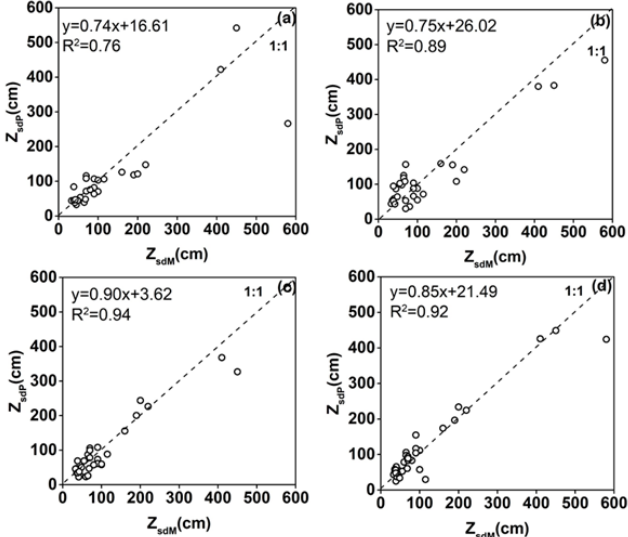
Figure 5. Models between measured Z sd and ( a ) red band reflectance, ( b ) the green:red band ratio, ( c ) red and blue band difference, and ( d ) chromaticity angle.